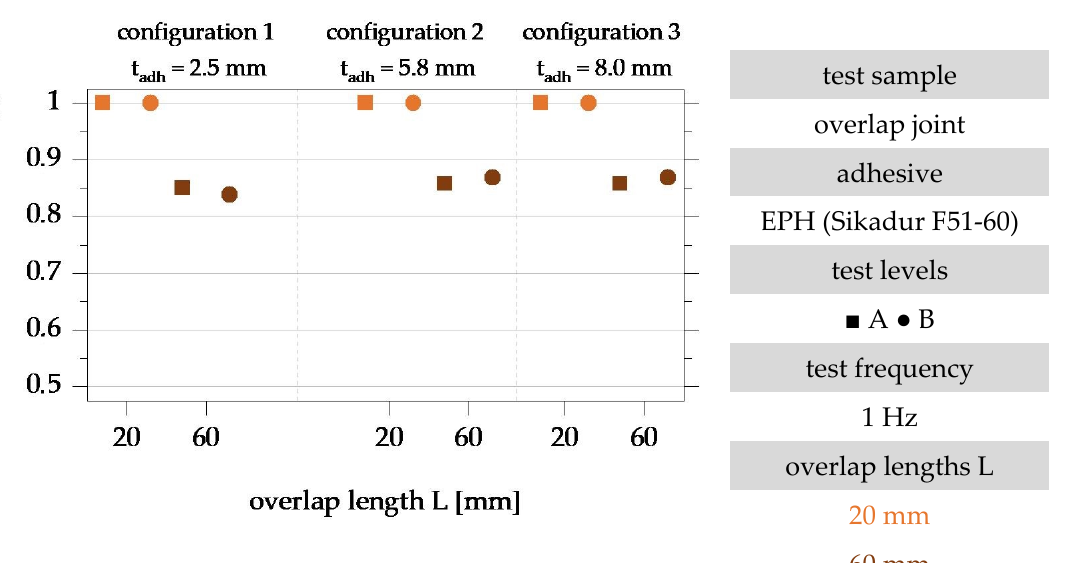
Figure 10. Evaluation of the influence of the overlap length on the loss factor of the overlap joint configurations 1, 2 and 3 with overlap lengths 20 mm and 60 mm in the test levels A and B for the test frequency 1 Hz; representation normalised to the loss factor of the specimens with overlap length 20 mm based on [22].